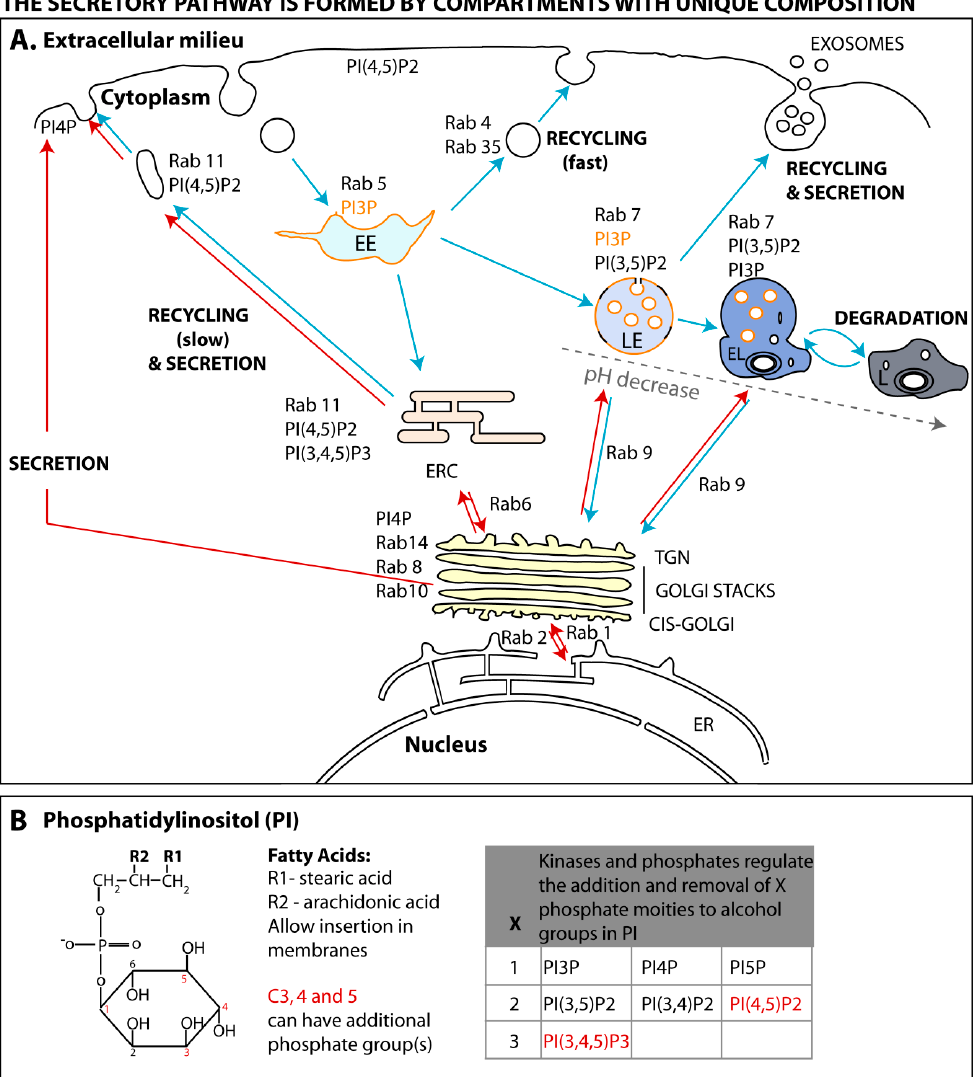
Figure 1. The endomembrane system of the eukaryotic cell and major Ras-related in brain (Rab) GTPases and phosphoinositides occupying its subdomains. ( A ) The eukaryotic cell is composed of several compartments. Trajectory of endocytosed material is depicted in blue arrows. Upon internalization, cargo is transported to the early endosome (EE), and either degraded upon passage through late endosomes (LE), endolysosomes (EL) and lysosomes (L), or recycled via a fast or a slow pathway that requires transfer from EE to endocytic recycling compartment (ERC). Secretory pathways from the trans-Golgi network (TGN) to the plasma membrane are highlighted in red. Note that at some points, exocytic and endocytic pathways intertwine. Rab GTPases and phosphoinositides occupy specific subcellular locations and are marked adjacent to corresponding compartments. Phosphatidylinositol-3-phosphate (PI3P) is highlighted in orange to facilitate illustration of its selective inclusion in internal luminal vesicles of LE; ( B ) The chemical structure of phosphatidylinositol is shown, highlighting carbon number of the sugar moiety in red. Fatty acids (R1, R2) in the glycerol moiety allow ligation to membranes. Carbon 3, 4 and 5 can be additionally phosphorylated by esterification of hydroxyl groups to originate seven isoforms, shown in the table. Isoforms found in the ERC (despite in minor amounts) are highlighted in red. Abbreviations include: PI4P: phosphatidylinositol-4-phosphate; PIP5: phosphatidylinositol-5-phosphate; PI3,5P2: phosphatidylinositol-3,5-biphosphate; PI3,4P2: phosphatidylinositol-3,4-biphosphate; PI4,5P2: phosphatidylinositol-4,5-biphosphate; PI3,4,5P3: phosphatidylinositol-3,4,5-